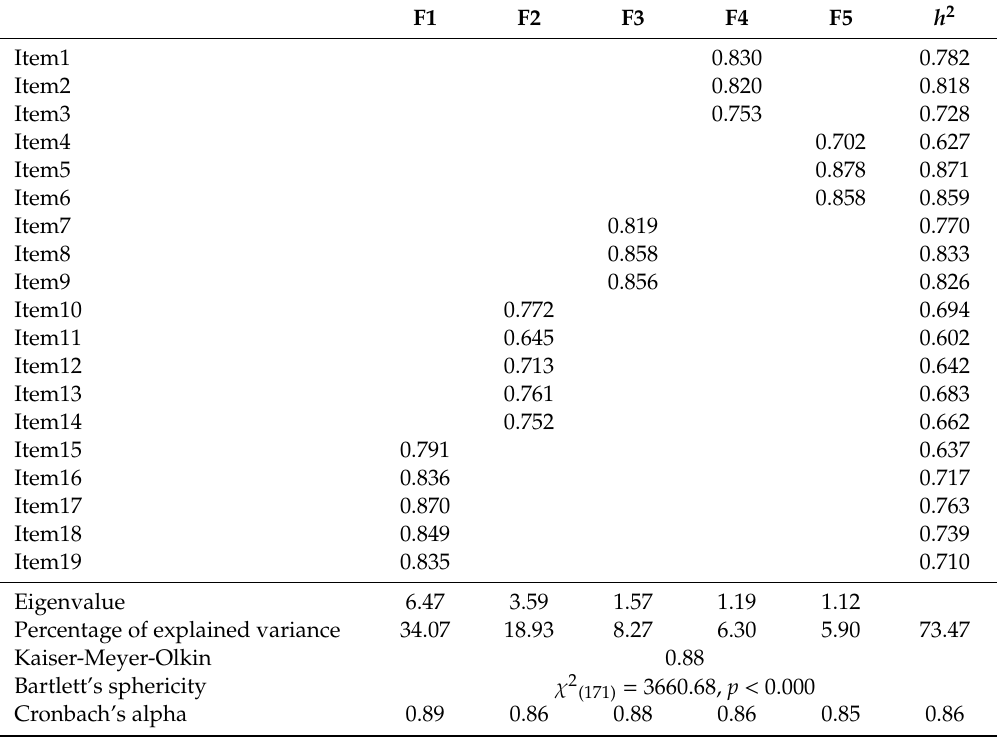
Table 1. Factor structure, communalities (h2), eigenvalues, Cronbach’s alpha and percentage of the explained variance (n = 330). Extraction method: Principal Component Analysis